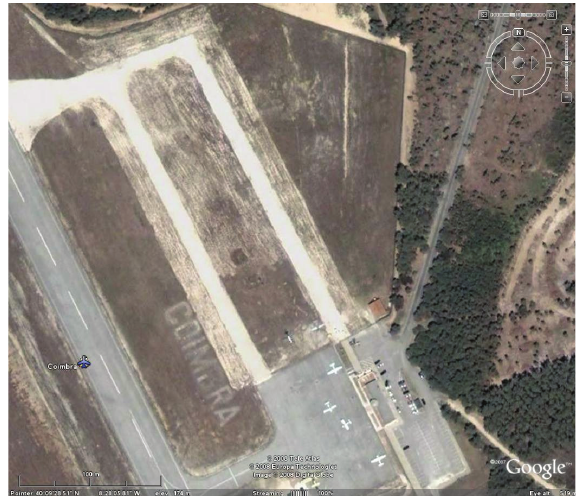
Figure 10: A satellite image of the flight area, the Coimbra City